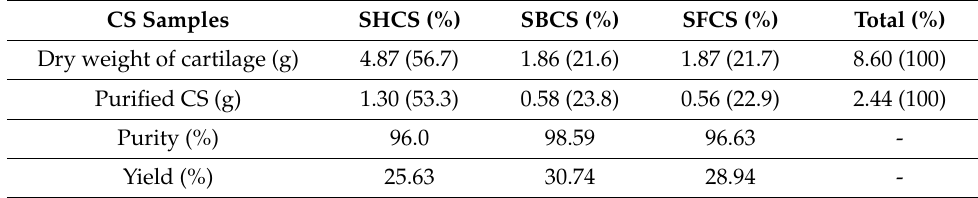
Table 1. The Purity and Yield of CS Preparations from Chinese Sturgeon Cartilage. CS Samples SHCS (%)